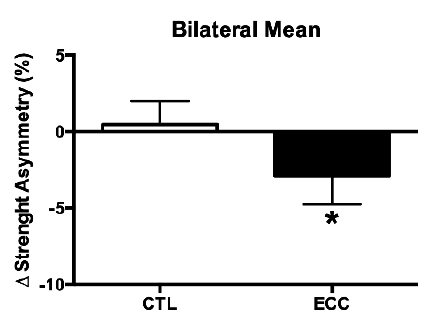
Figure 2. Comparison of the changes (Post-Pre) in muscular strength asymmetry after training (%) between CTL and ECC. Δ Strength asymmetry between Lower Limbs (% of change LL dominant versus LL non-dominant). * p <0.05. Results are shown as mean